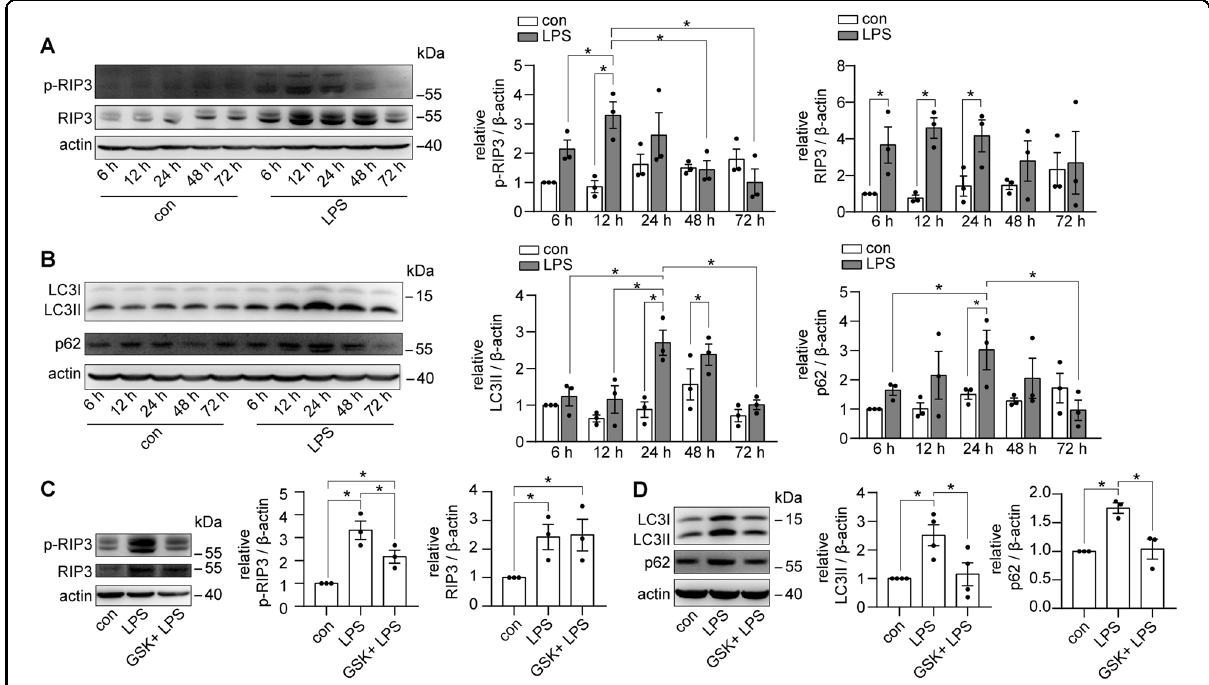
Fig. 1 RIP3 was activated to inhibit autophagy in septic AKI mice. A Kidney tissues were collected from C57BL/6 mice treated with LPS or sterilized saline (con) for immunoblot of phosphorylated RIP3 (p-RIP3, a marker of RIP3 activity) and total RIP3. p-RIP3 and RIP3 expression, against β -actin expression, were increased in the kidneys of LPS-induced mice ( n = 3). B Immunoblot showed an accumulation of the expression of LC3II (marker for autophagosome) and p62 (substrate for autophagy) in the kidneys of LPS-induced mice ( n = 3). C C57BL/6 mice were treated with sterilized saline (con), LPS, or LPS plus GSK ’ 872 (GSK) for 12 h. Immunoblotting showed that GSK attenuated the increased p-RIP3 in the kidneys of LPS-induced mice ( n = 3). D C57BL/6 mice were treated with sterilized saline (con), LPS, or LPS plus GSK for 24 h. Immunoblot showed that GSK attenuated the accumulated LC3II and p62 in the kidneys of LPS-induced mice ( n = 3 – 4). * P <